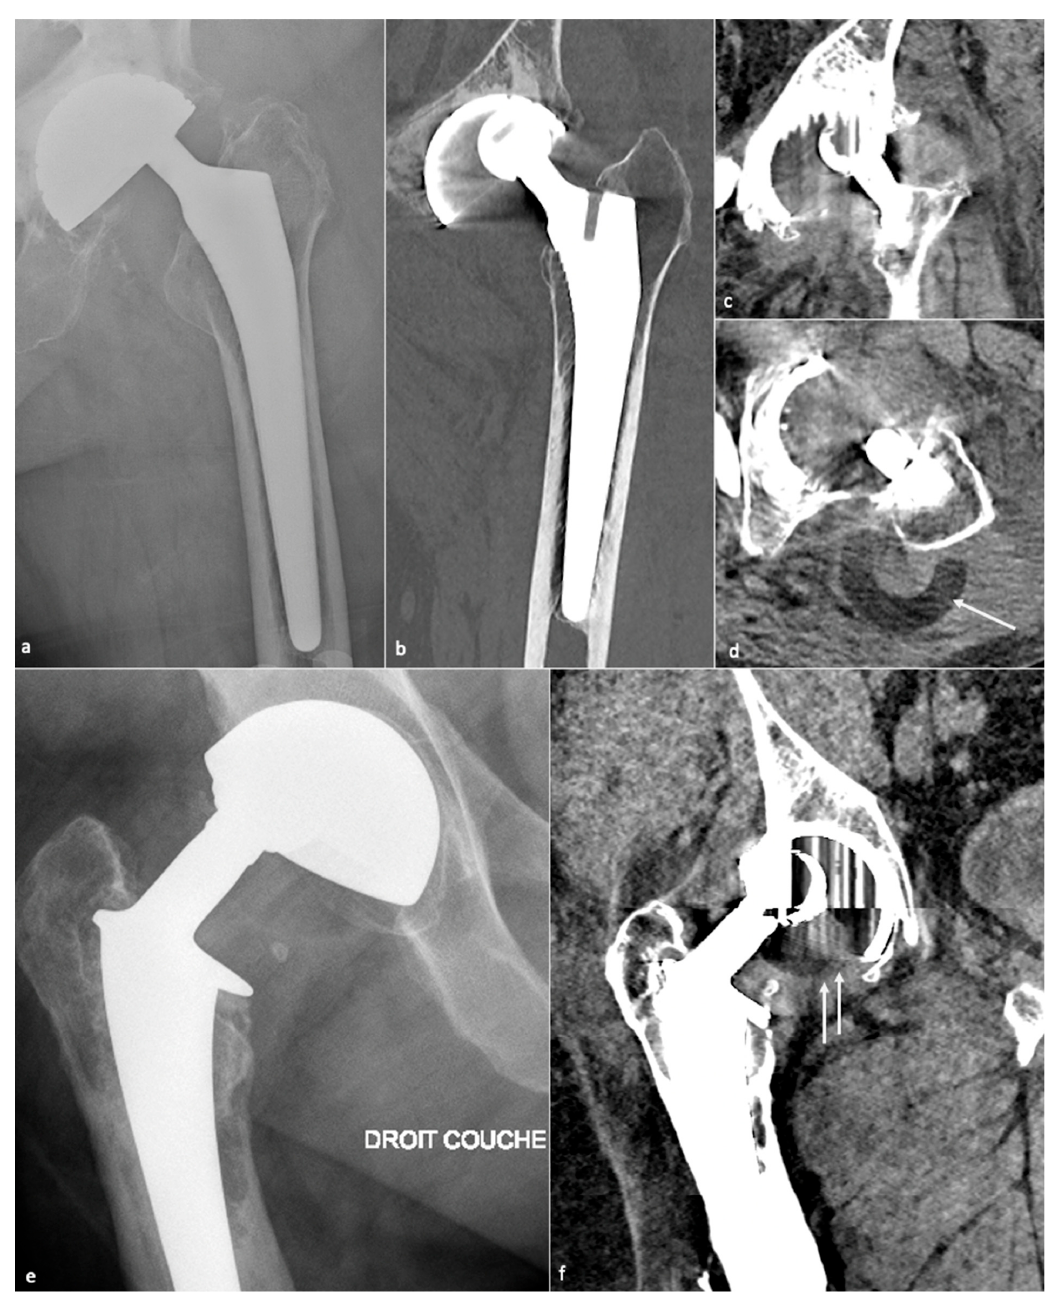
Figure 16. Polyethylene dislocations. An intra-prosthetic dislocation is shown on ( a ) an anteropos- terior radiograph and ( b ) a coronal CT-scan with bone kernel where out-of-round of the femoral head is seen. Using soft tissue kernel in ( c ) frontal and ( d ) axial CT-scan slices, no polyethylene is seen in its usual position in ( c ) but is depicted behind the great trochanter in ( d ) (white arrow). In another patient, an intra-prosthetic dislocation is shown on ( e ) an anteroposterior hip radiograph where exenteration of the femoral head is seen, and on ( f ) a frontal CT-scan slice where the polyethylene (double white arrow) is located